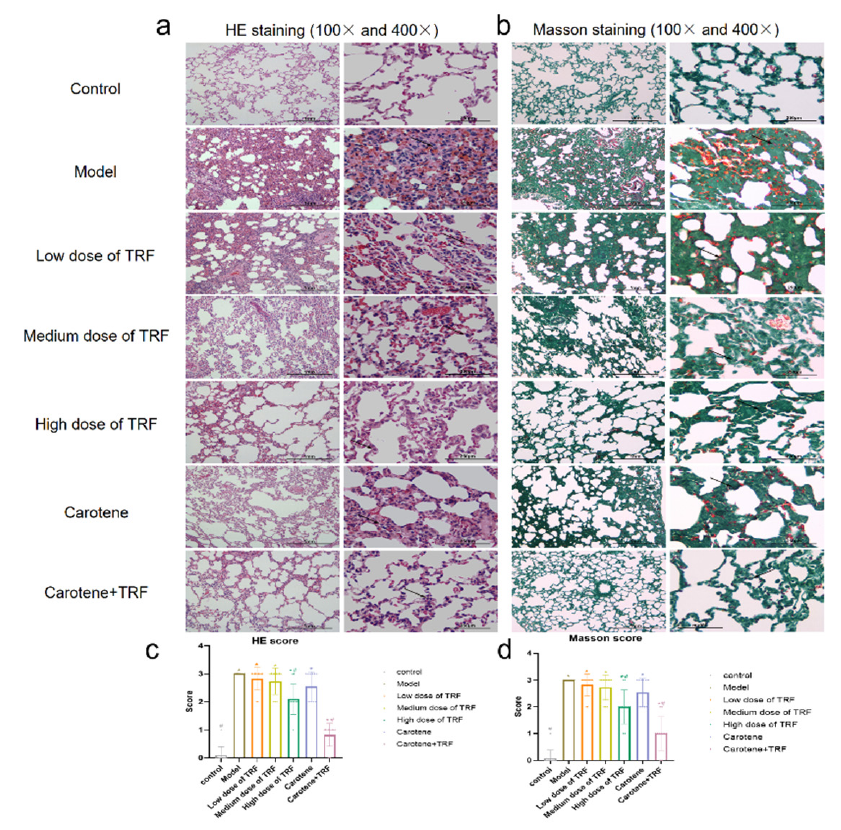
Figure 2. TRF and carotene inhibited BLM-induced PF. ( a ) Representative HE staining of the lungs, with original magnification ×100 and ×400; ( b ) representative Masson’s trichrome staining of the lungs, with original magnification ×100 and ×400; ( c ) quantitative analysis of lung inflammation, n = 11; ( d ) quantitative analysis of the collagen, n = 11. Note: compared with CON group, # represents p < 0.05; compared with MOD group, * represents p < 0.05.